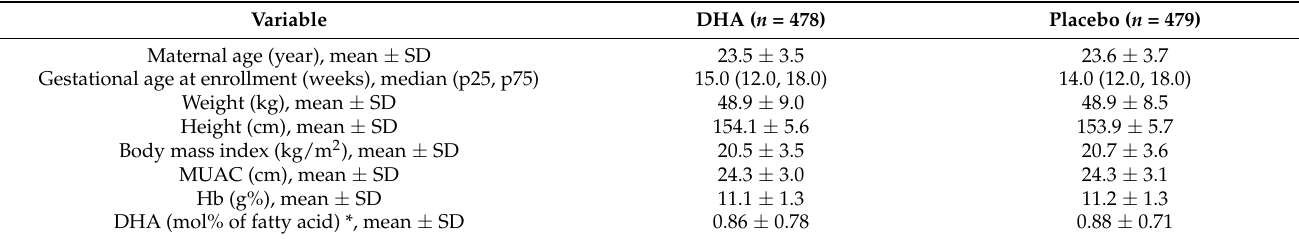
Table 1. Maternal anthropometrics and DHA level according to treatment group at randomization.